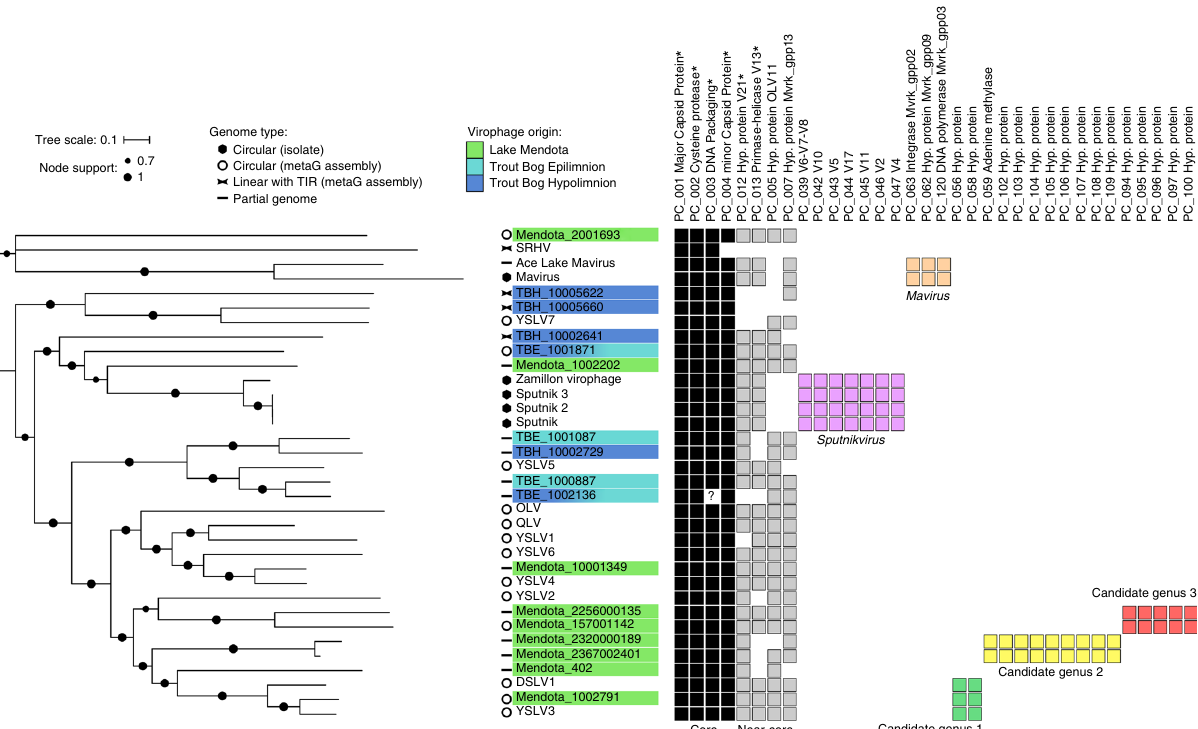
Fig. 1 Phylogeny and summarized gene content of virophage genomes. The maximum-likelihood phylogenetic tree was computed from a concatenated alignment of four core genes (major and minor capsid proteins, DNA packaging enzyme, and Cysteine protease). SH-like support are indicated on nodes, and branches with < 50% support are displayed as multifurcations. The detection of key virophage genes is indicated for each genome on the right side. These key genes are classi fi ed as “ core ” (detected in all but one genome), ‘ near-core ’ (detected in > 68% of virophage genomes), and ‘ signature genes ’ , i.e., genes speci fi c to and detected in all members of known and newly proposed virophage genera. A question mark denotes the absence of genes similar to the DNA packaging enzyme in contig TBE_1002136, which is likely due to this genome being only a partial assembly, based on the comparison of this genome with the closely related TBE_1000887 (Supplementary Fig. 3). Six core genes previously identi fi ed from the comparison of isolate virophage genomes are highlighted with a star. DSLV, Dishui Lake virophage; OLV, Organic Lake virophage; QLV, Qinghai Lake virophage; SRHV, Sheep Rumen